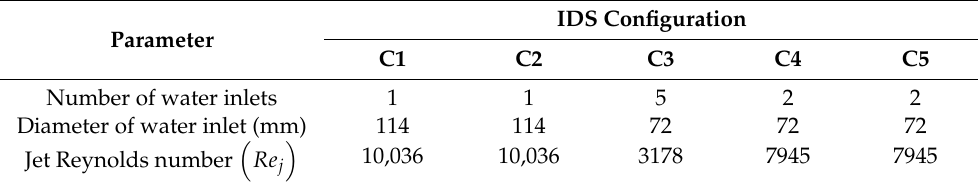
Table 1. Jet Reynolds number of evaluated IDS